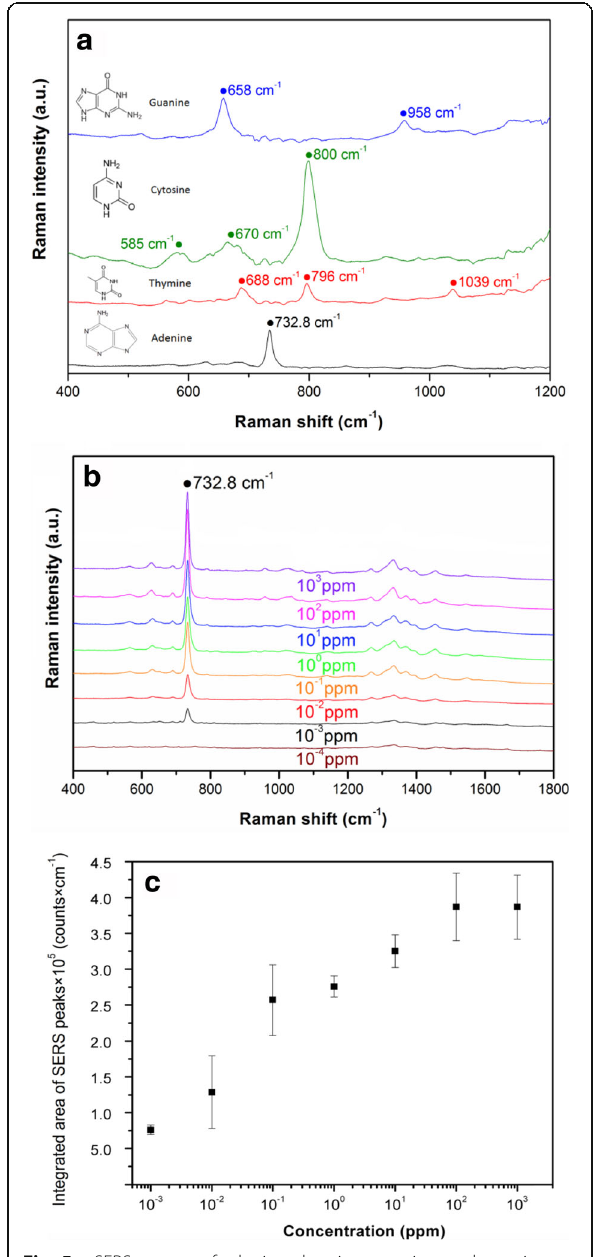
Fig. 5 a SERS spectra of adenine, thymine, cytosine, and guanine (10 − 4 M). b SERS spectra of adenine at different concentrations (from 10 − 4 to 10 4 ppm). c Integrated area of 732.8 cm − 1 peak of adenine ) as a function of ( I (cid:2) 732 : 8